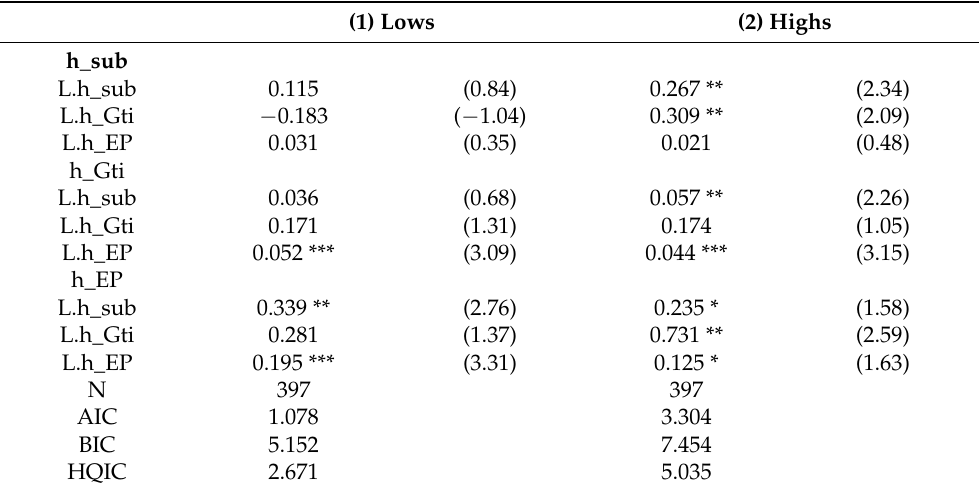
Table 7. Summary of GMM estimation results of PVAR model based on corporate profitability